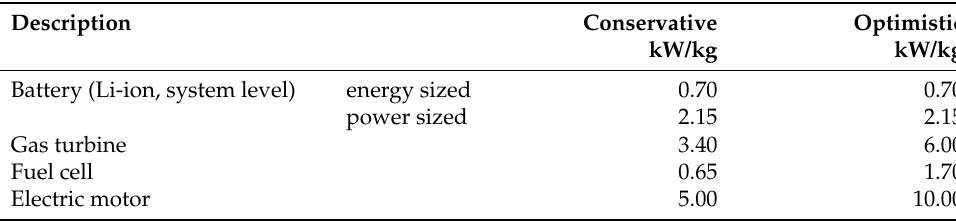
Table A3. Assumed specific powers of powertrain components.